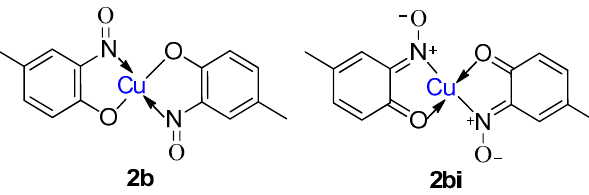
Figure 3. The possible tautomers of copper(II) bis (4-methyl-2-nitrosophenol), (2b, 2bi).